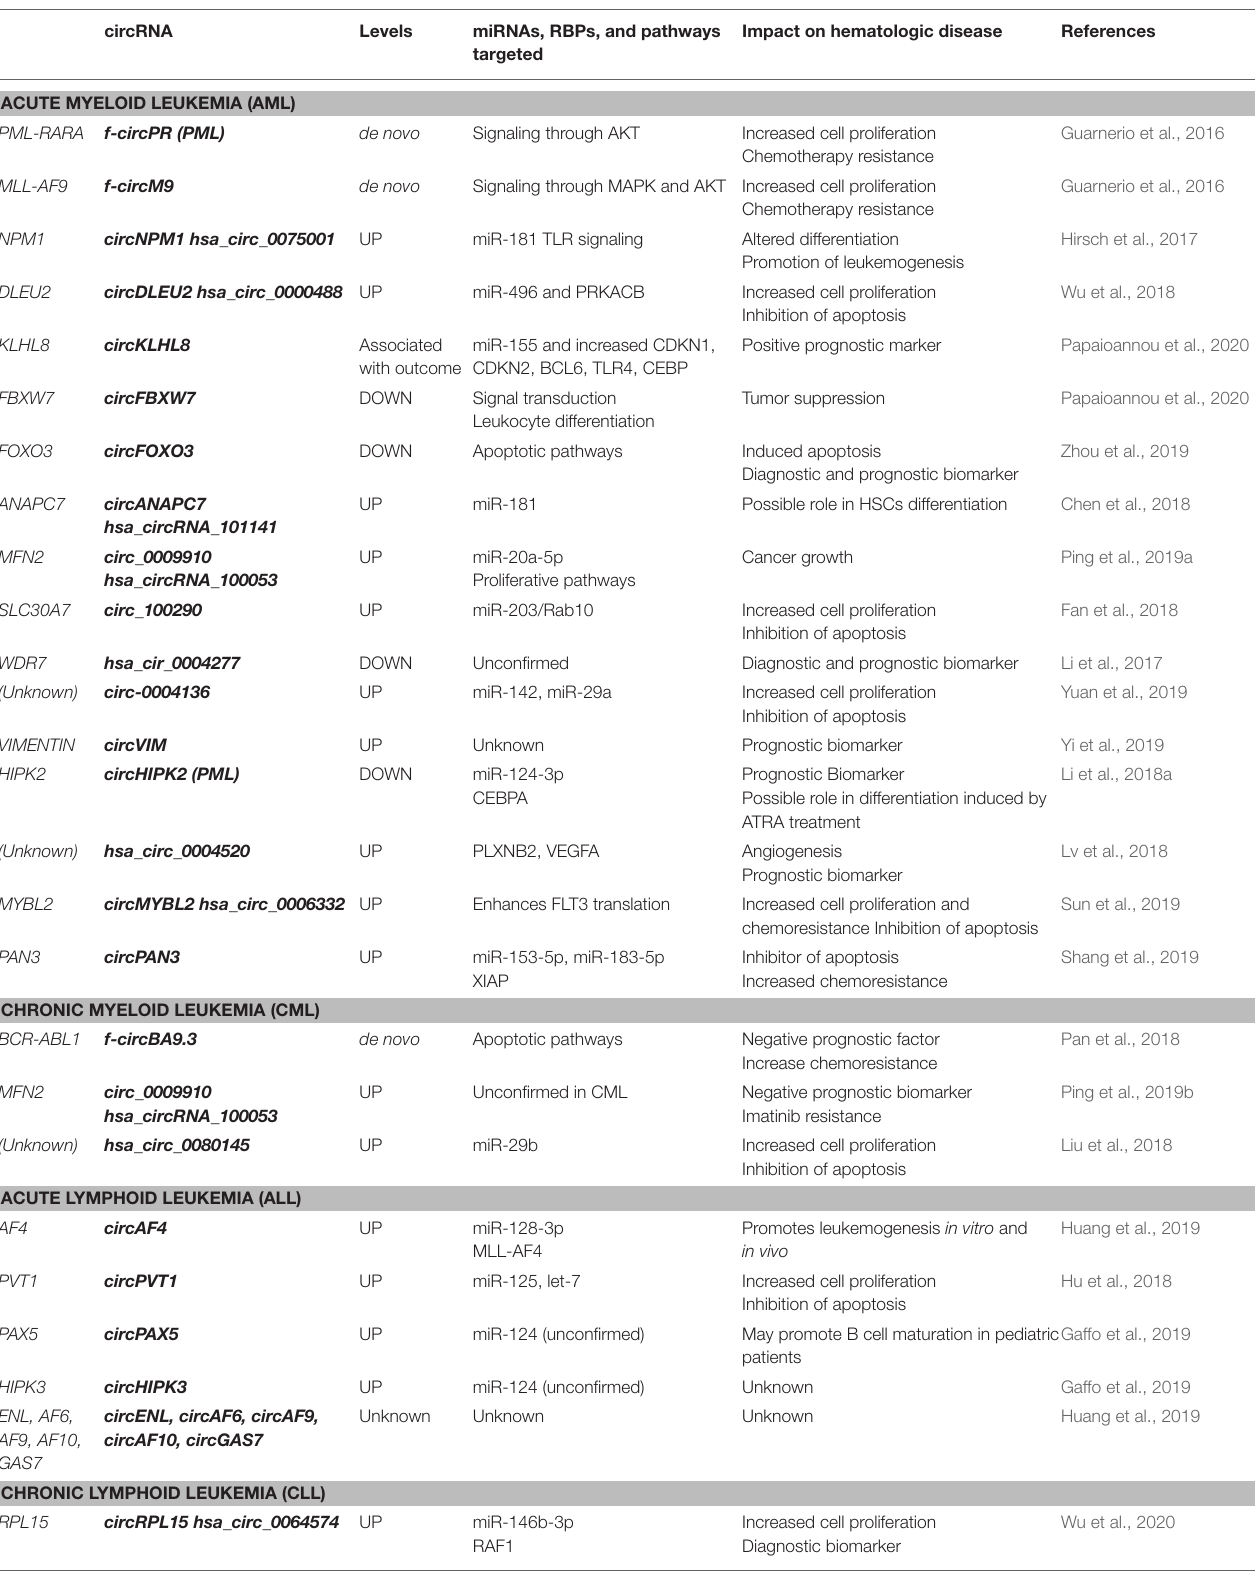
TABLE 1 | Circular RNAs implicated in hematological